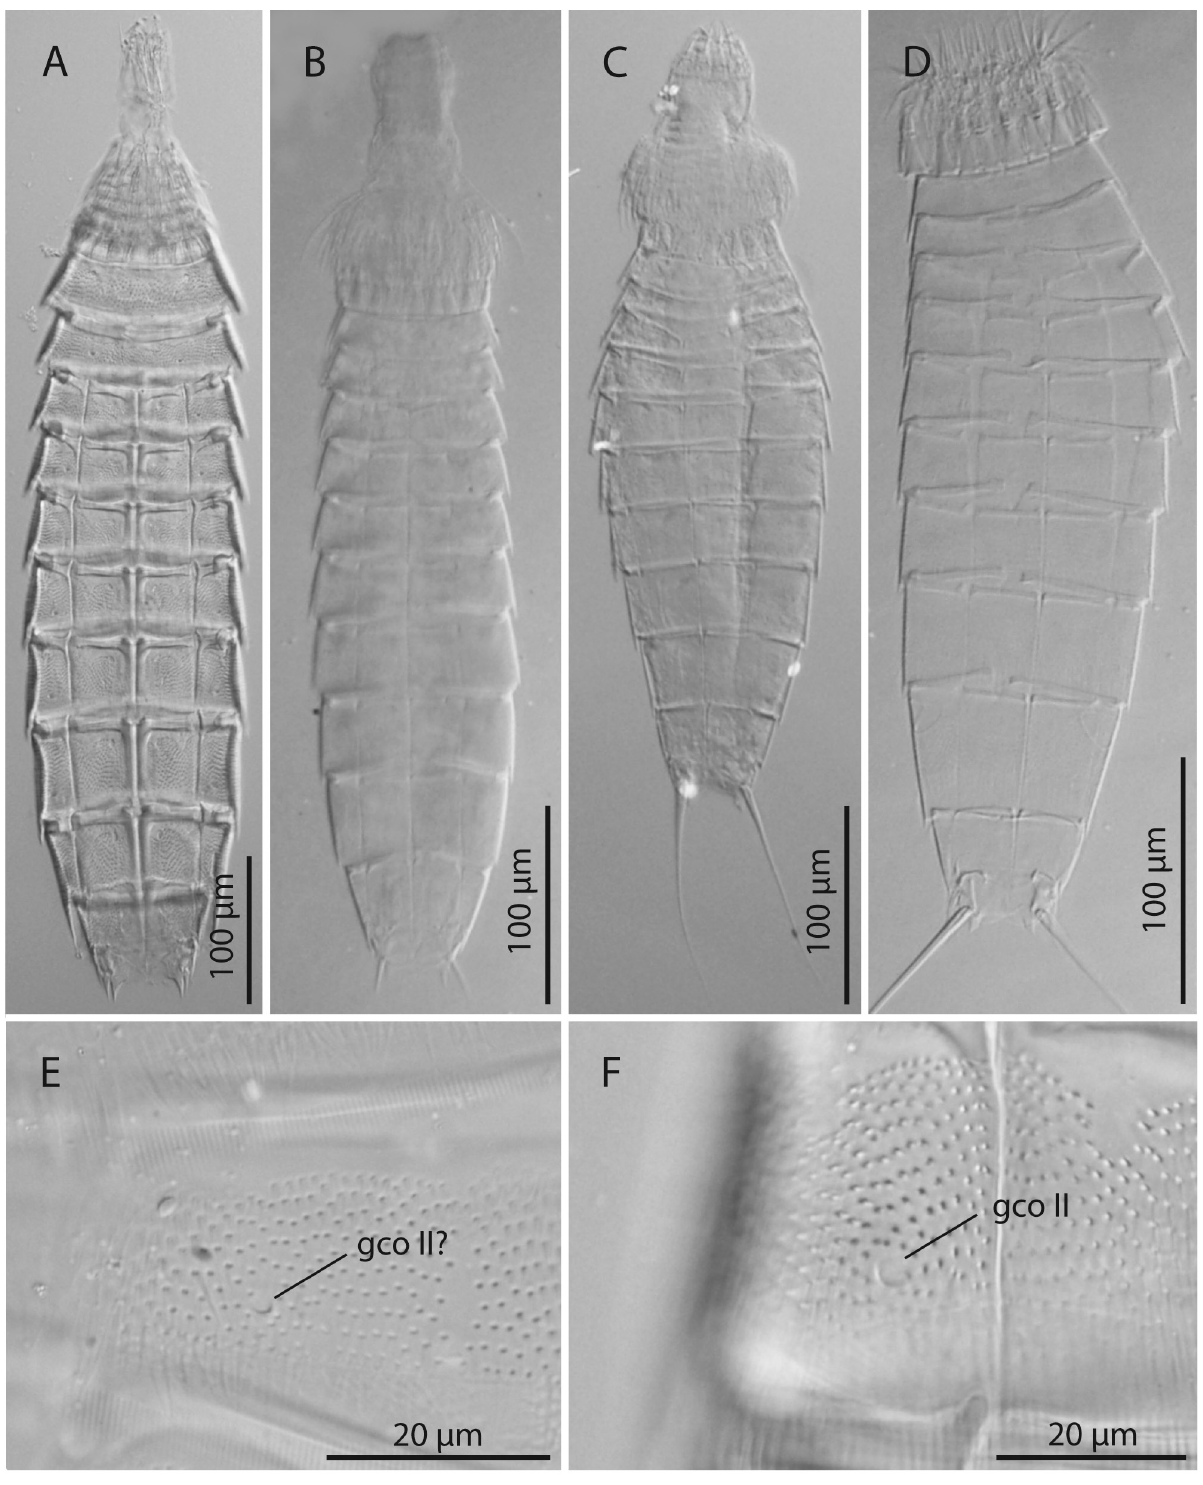
Fig . 2. – Light microscope photos showing selected species of Echinoderes . A, Echinoderes rex n. sp. holotypic female, ventral view; B, E. coulli , USNM 54388, paratypic female type II, ventral view; C, E. teretis , ZMUC KIN-454, female, ventral view; D, E. maxwelli , 12.22.1., holotypic male, ventral view; E, E. maxwelli , 12.22.2., allotypic female, detail from segment 6, showing putative modified type II glandular cell outlet; F, E. rex n. sp., holotypic female, detail from segment 6, showing modified type II glandular cell outlet. Abbreviations: gco II, modified glandular cell outlet type